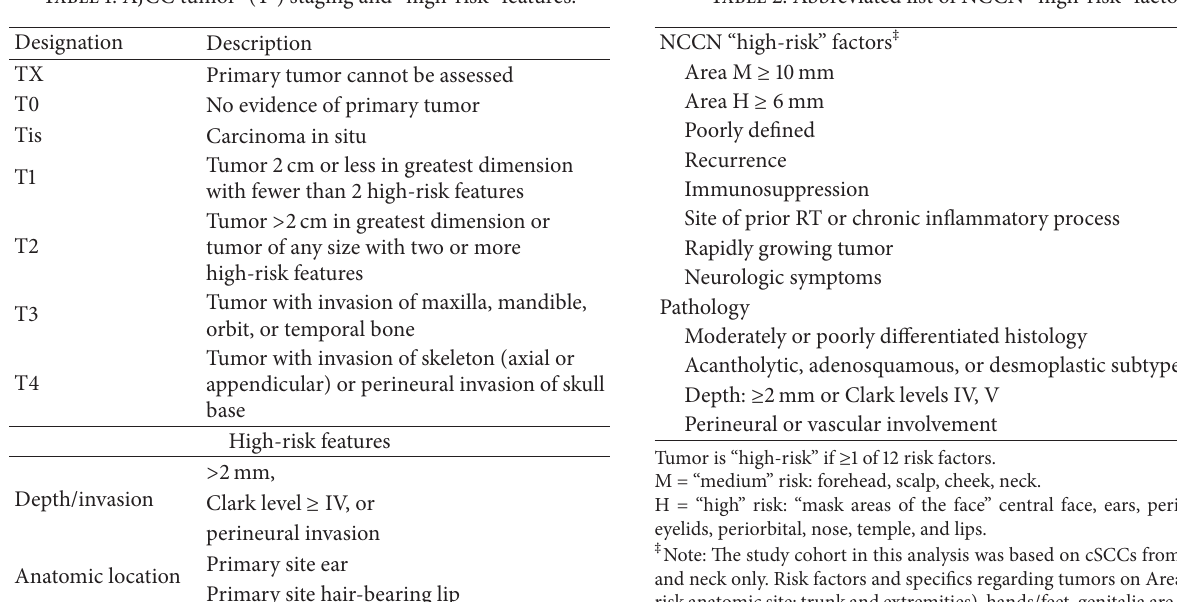
Table 1: AJCC tumor- (T-) staging and “high-risk” features. Table 2: Abbreviated list of NCCN “high-risk” factors.